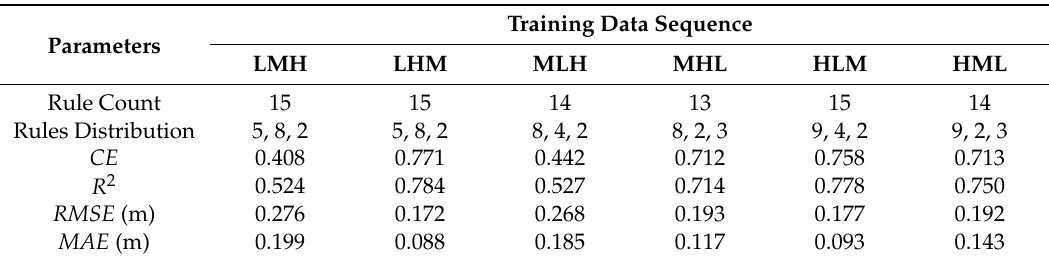
Figure 9. Comparison of observed discharge time-series with DENFIS rule number progression for training combination HLM in the Sungai Kayu Ara catchment. Table 8. Rules count and overall DENFIS performance in simulating 3 years of testing dataset in Dandenong catchment trained with Low (L), Medium (M), and High (H)